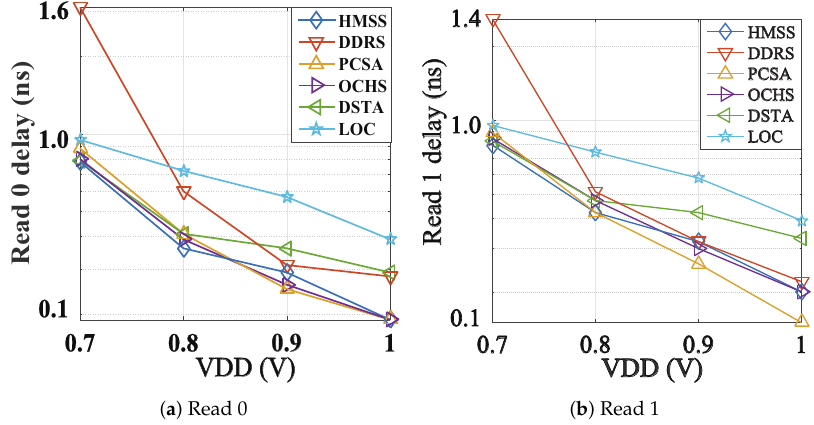
Figure 5. The comparison of sensing latency with ( a ) reading 0 and ( b ) reading 1. The dynamic power consumption is evaluated through averaging the power dissipa- tion in several operating phases. Figure 6 shows the comparison of the dynamic power of ‘P’ state and ‘AP’ state sensing, at the voltage range of 0.7 V to 1 V. Notice that DDRS has the largest dynamic power and OCHS has the lowest dynamic power. The dynamic power consumption of LOC, PCSA and the proposed HMSS is in the middle level, whereas the DSTA is slightly higher than the OCHS. Due to the triple paths from V DD to ground, DDRS, PCSA and the proposed HMSS achieve the largest dynamic power, whereas the proposed HMSS is designed with the lowest power consumption compared with DDRS and PCSA.